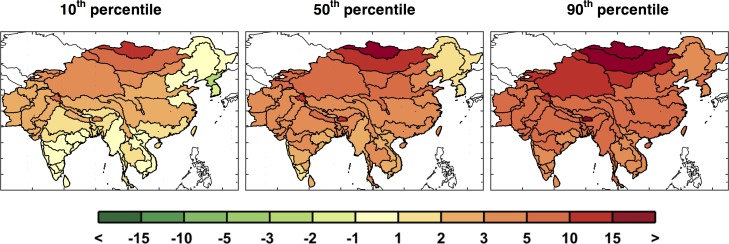
Changes from baseline in irrigation requirement (%) calculated point-wise by ASR, showing changes in decadal averaged ASR irrigation requirement from the baseline to the future scenarios averaged over 2041–2050 for the 10th, 50th, and 90th percentiles.